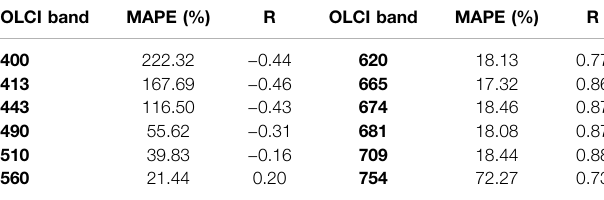
TABLE 4 | Validation of atmospheric correction using 6SV algorithm (n = 45). OLCI band